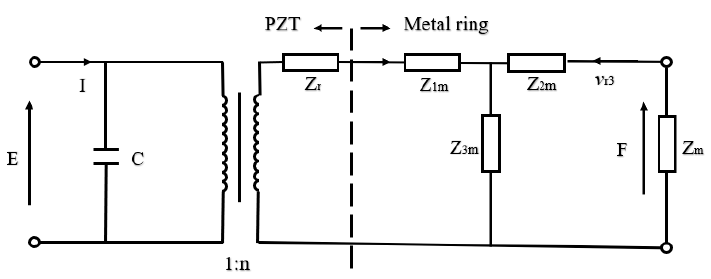
Figure 9. Electromechanical equivalent circuit of PZT with metal ring.